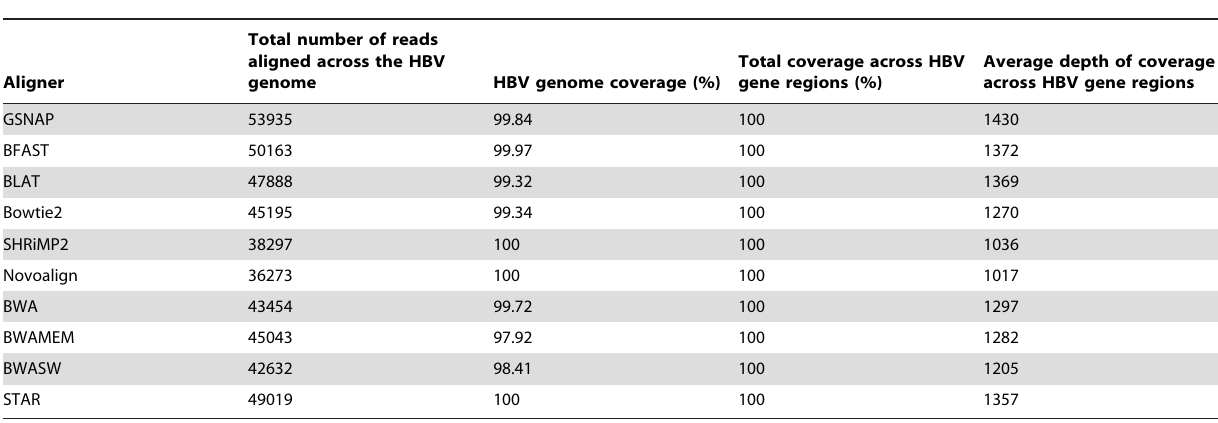
Table 12. Alignment results across the HBV and its gene regions.